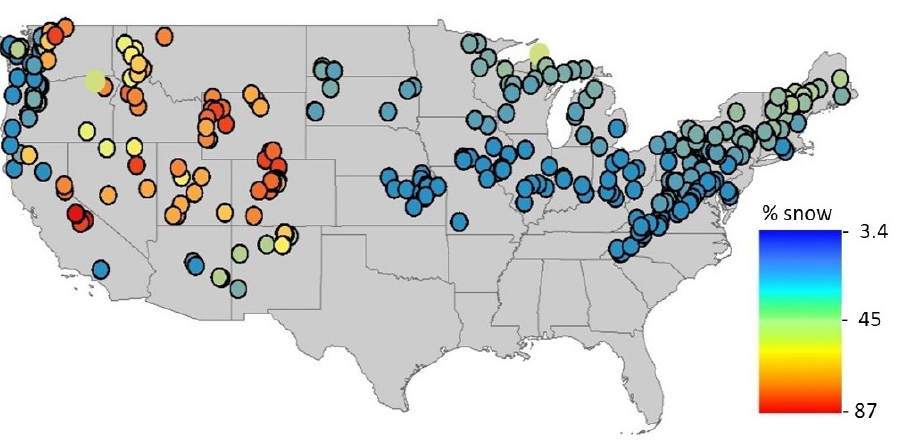
Figure 1. Location of the considered catchments and percentage of precipitation falling as